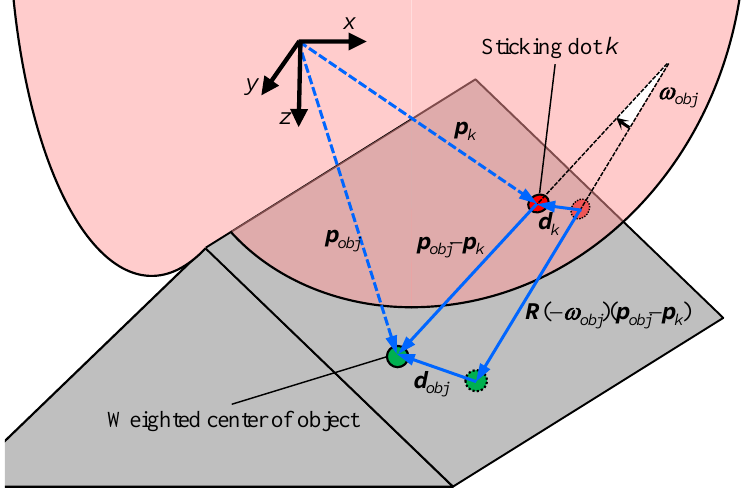
Figure 4. Geometric relationship between the object and the sticking dot k